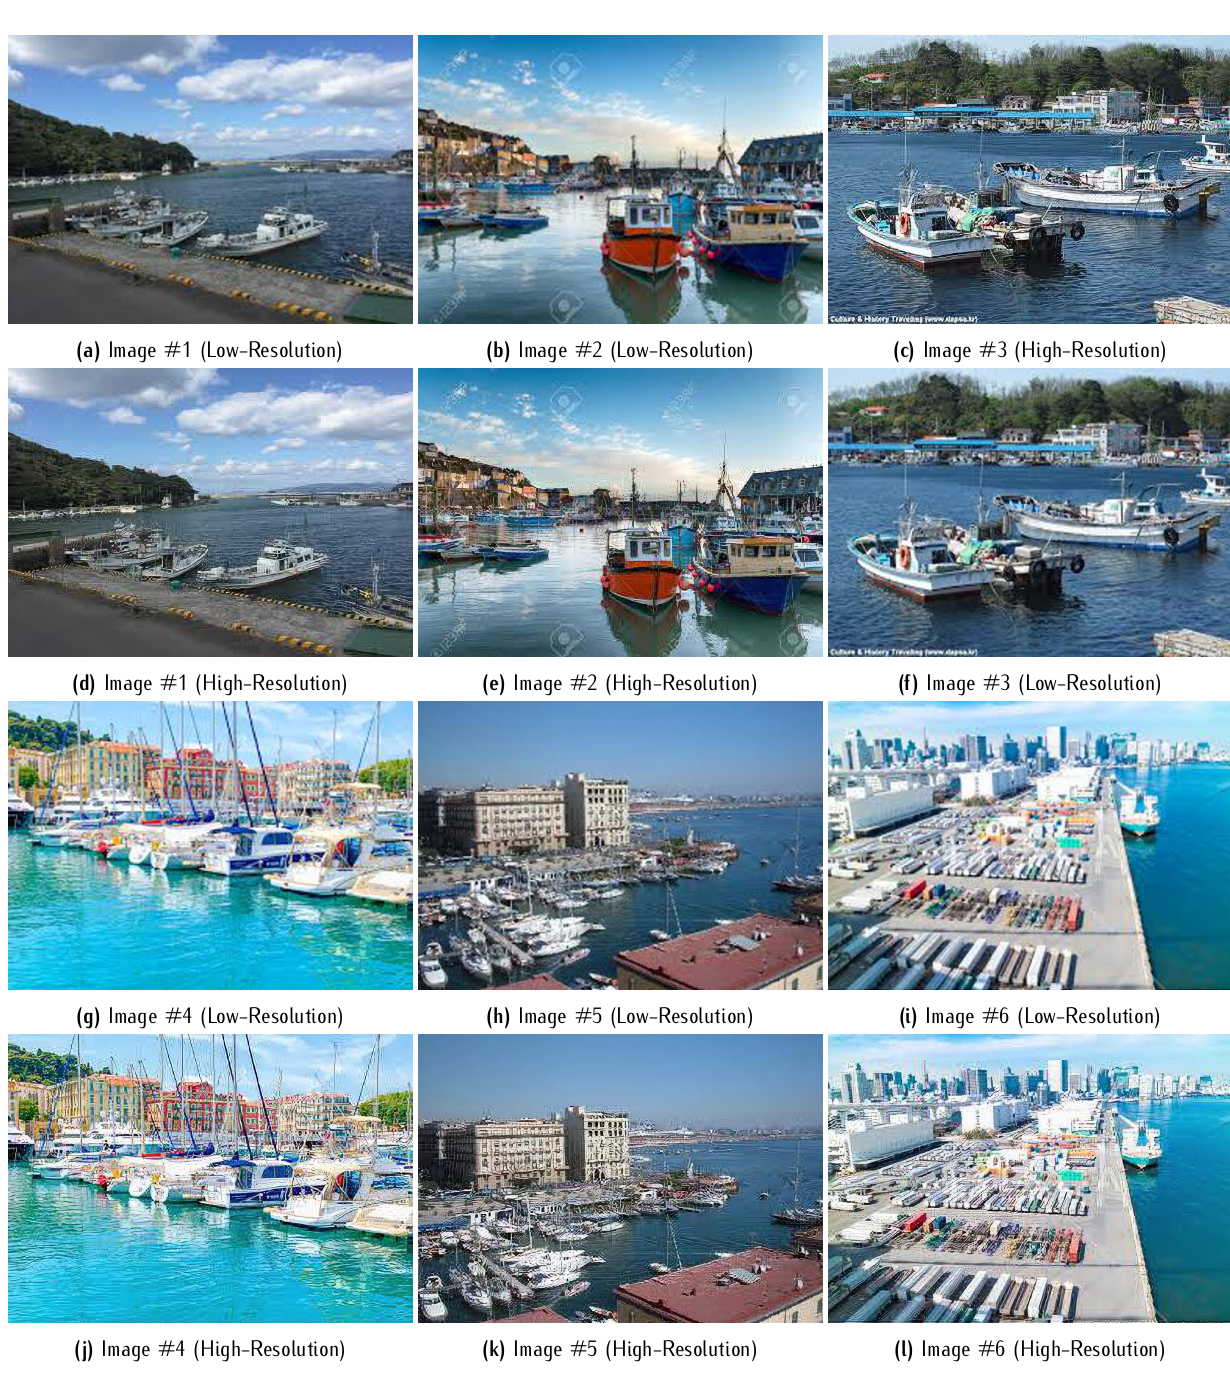
Figure 2. Super-Resolution Computation Results. Note that the model for Low-Resolution is bicubic which has no hidden layers. sacrificing certain amounts of performance if the